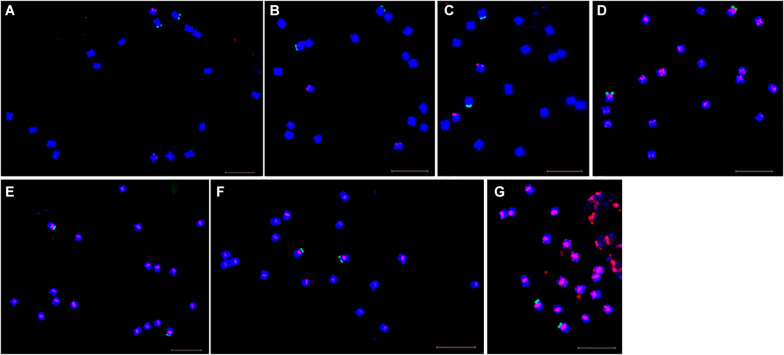
Localization of seven satellites on metaphase chromosomes of B. vulgaris using fluorescence in situ hybridization. Blue are DAPI stained chromosomes, green signals show chromosomal localization of 45 rDNA, The satellite DNAs were labeled with Texas red (red signal). (A) Probe BvuSat01-59-s (red). (B) Probe BvuSat02-141-s. (C) Probe BvuSat03-141-s. (D) Probe BvuSat04-159-s. (E) Probe BvuSat05-329-s. (F) Probe BvuSat06-358-s, (G) Probe BvuSat07-358-s. Bar indicates 10 μm.